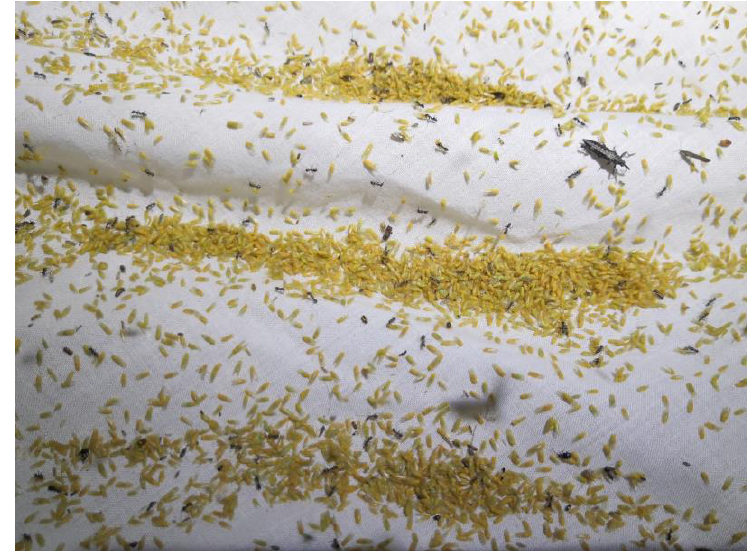
Figure 2. Creiis sp. “H” at light trap, Wide Water Reserve, near Taroom, Queensland (Photo by Peter Rühr).